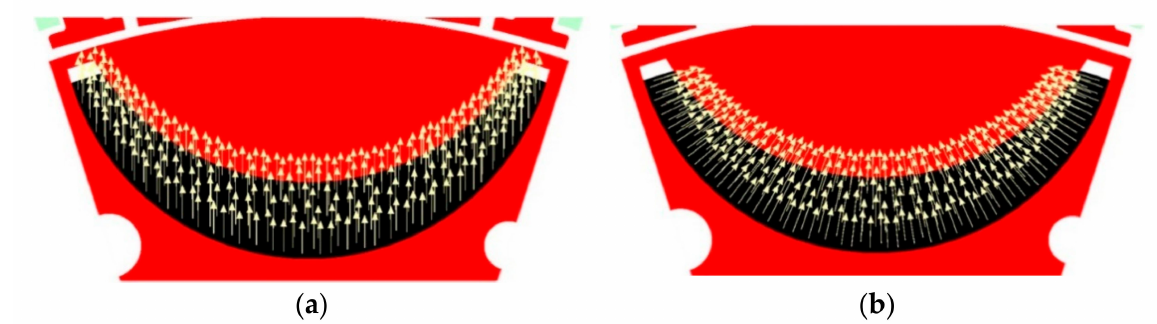
Figure 7. ( a ) Parallel magnetization; ( b ) Radial